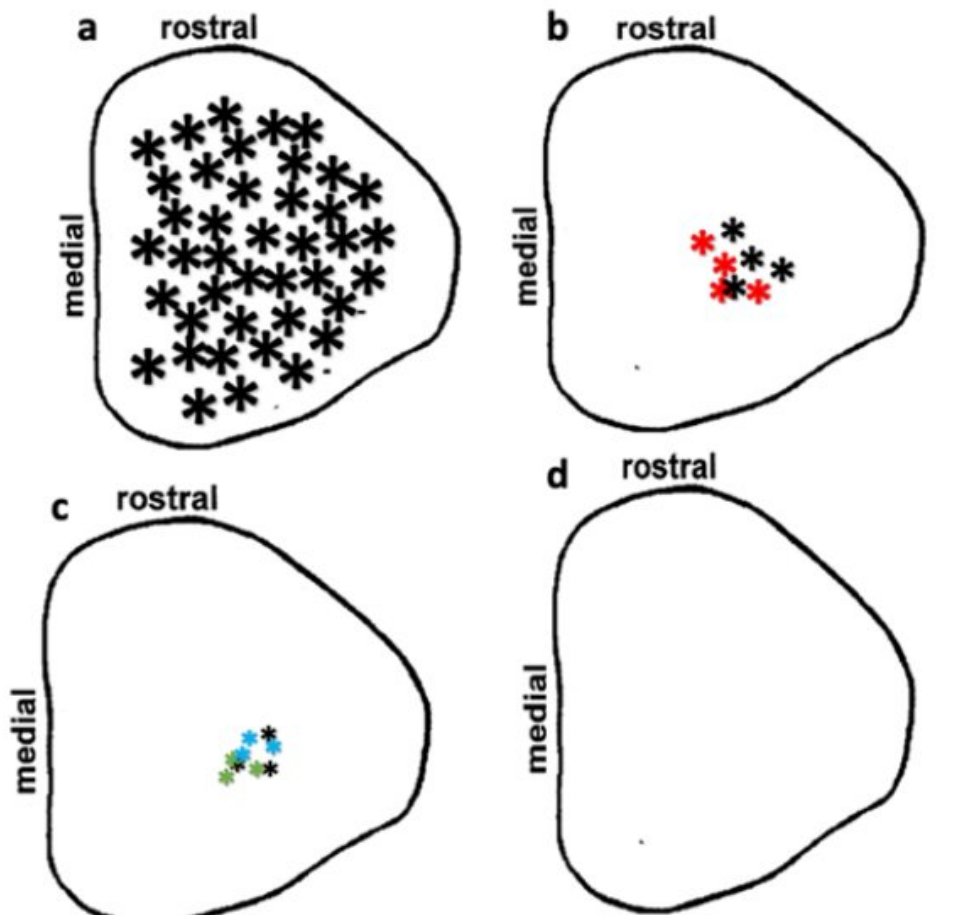
Figure 5. Visual activities recorded from the SC of 11-month-old immunodeficient RCS rats. Map properties of SC-evoked responses from individual rats are represented by colored asterisks. Larger asterisks show higher light sensitivity in the SC. ( a ) Age-matched normal rat. ( b ) * Rat # 6005 and * Rat # 6012 . ( c ) * Rat # 6001 , * Rat # 6006 , and * Rat # 6011 . Based on morphological examination,